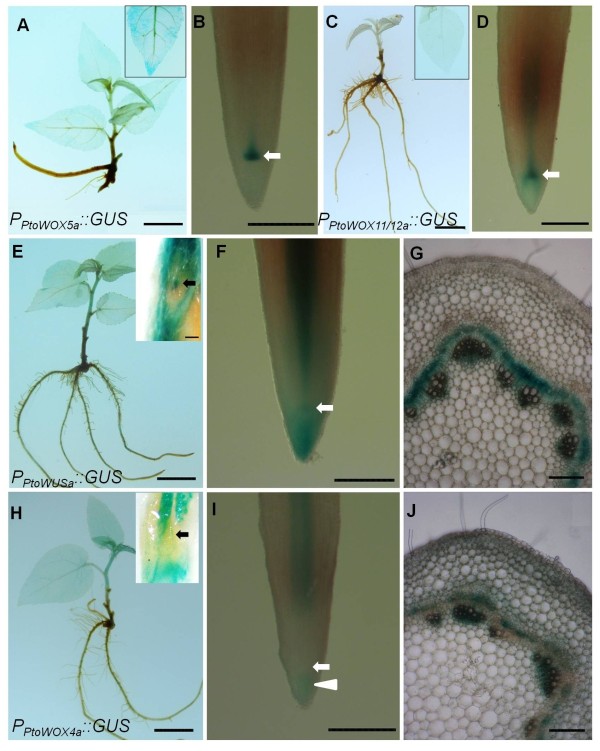
GUS-staining assays of four PtWOX promoters. (A–B) GUS expression in (A) 2-week-old sapling and (B) root of PPtoWOX5a::GUS-expressing poplar plants. The insert in A shows GUS expression in the leaf, and that the GUS expression in B is mainly focused on a small area immediately behind the root cap in AR tips. (C–D) GUS expression in (C) 2-week-old sapling and (D) root tip of PPtoWOX11/12a::GUS-expressing poplar plants. GUS is expressed in a small area immediately behind the root cap in AR tips, and the insert in C shows no GUS expression in leaf. (E–G) GUS expression in (E) 2-week-old sapling, (F) root including a small area behind the root cap indicated by an arrow, and (G) the CAM zone of PPtoWUSa::GUS-expressing poplar plants. The insert in E shows GUS expression in the SAM area in a halved shoot apical part. (H–J) GUS expression in (H) 2-week-old sapling, (I) root tip and (J) stem of PPtoWOX4a::GUS-expressing poplar plants. The insert in H shows no GUS expression in the SAM area in a halved shoot apical part. The bar represents 1 cm in A, C, E, and H; 1 mm in D; 0.5 mm in B, F, and I; and 0.1 mm in G, J, and the inset of E.